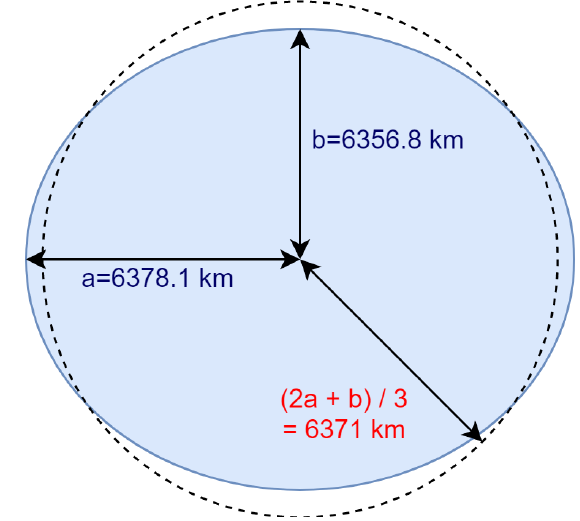
Figure 2. Radius of Earth: ( a ) radius from the center of Earth to a point on the equator; and ( b ) radius from the center of Earth to the pole. Average radius of Earth: 2 a + b